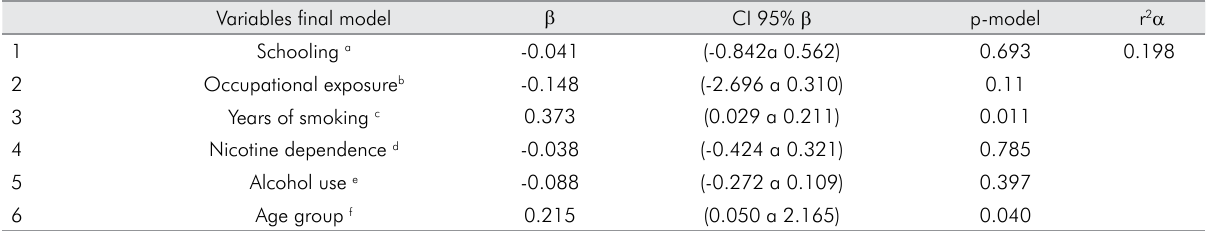
Table 7. Multiple linear regression analysis of the number of NCCLs.